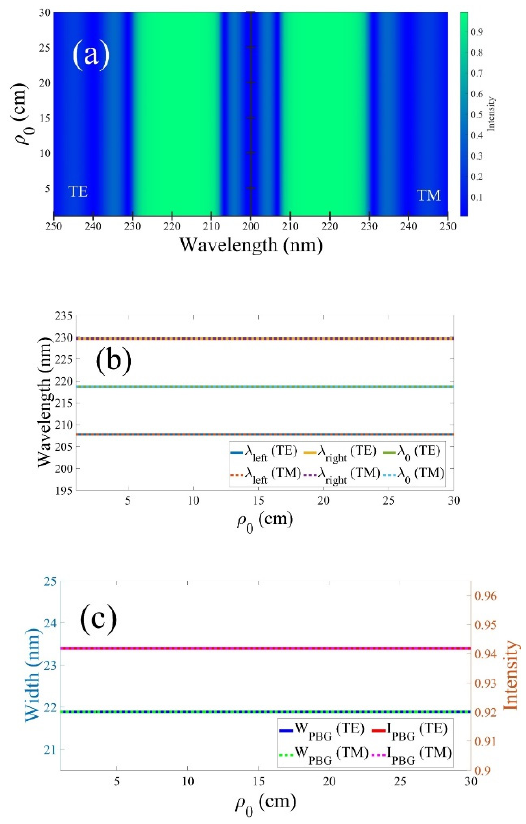
Figure 6. The influence of varying inner core radius for both 𝑇𝐸 and 𝑇𝑀 polarizations on the re- flectance of the proposed APC ( a ), the PBG position ( b ), and the PBG’s width 𝑊 (cid:3017)(cid:3003)(cid:3008) and average intensity 𝐼 (cid:3017)(cid:3006)(cid:3008) ( c